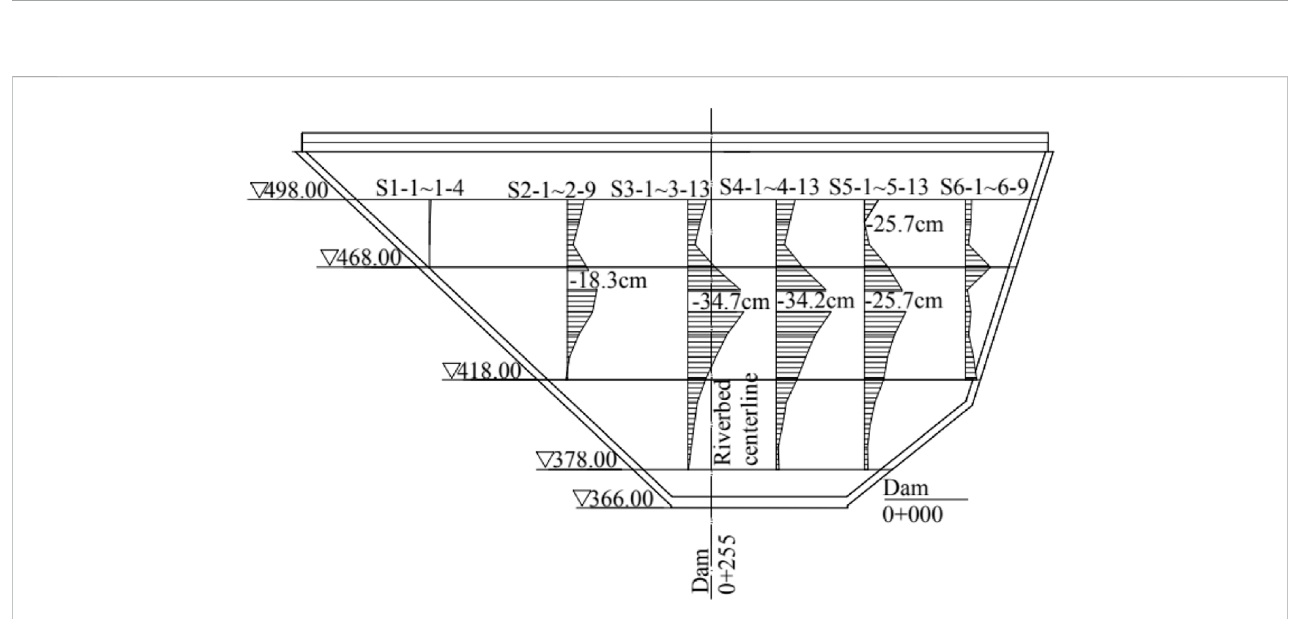
FIGURE 9 Vertical displacement of extrusion-sidewall in March